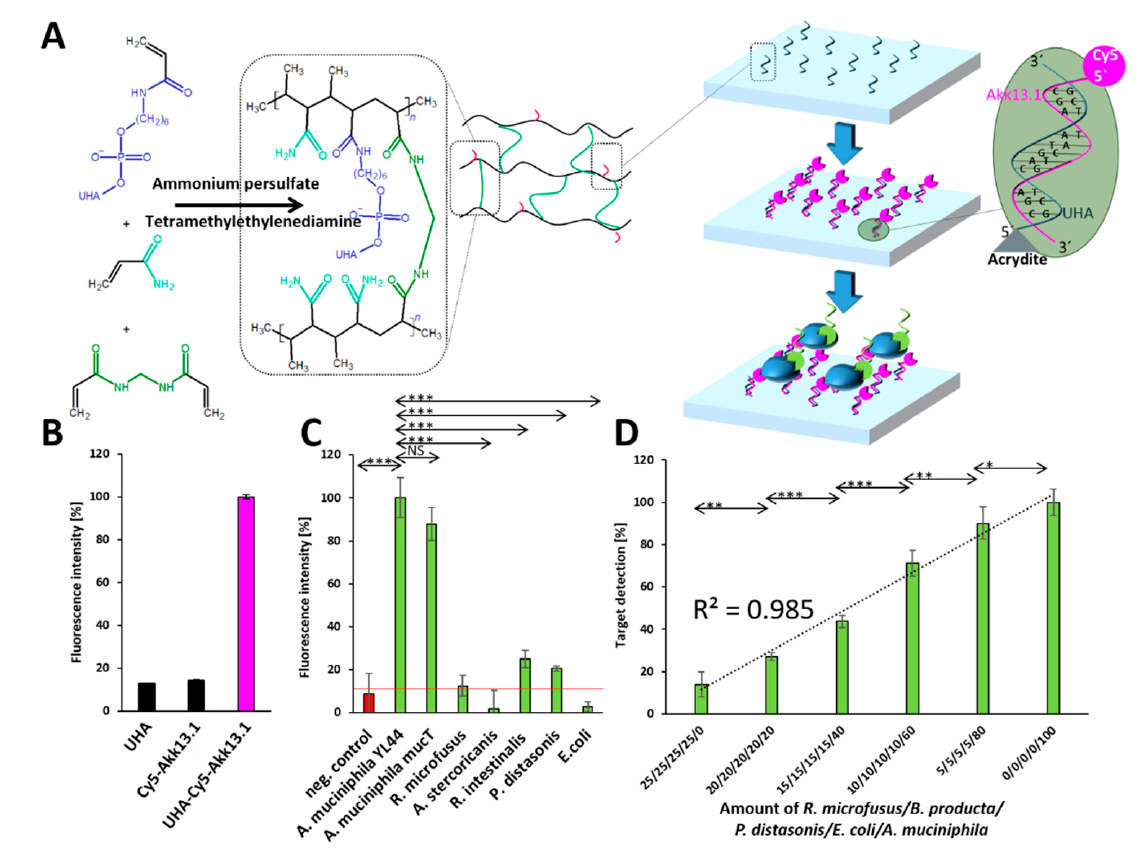
Figure 6. Design of an Akk13.1 based functional material for future biosensor applications ( A ) Reaction mechanism of the prototype aptamer-polyacrylamide based A. muciniphila detection system. The polyacrylamide-gel is modified by a universal hybridization anchor (UHA) consisting of an acrydite-modified single stranded DNA sequence complementary to the flanked regions of Akk13.1. The complementary primer binding sites of the Cy5-labeled aptamer Akk13.1 (Cy5- Akk13.1) are bound to the UHA and are able to catch specific A. muciniphila out of a sample. The second Oregon green 488 labeled “detection” aptamer Akk13.1 binds to the immobilized bacteria. ( B ) Binding control of the “catching” aptamer to the acrylamide modified primer polymerized to the hydrogel. There is a high amount of aptamer binding to the modified polyacrylamide-gel in comparison to unmodified polyacrylamide-gel ( C ) Specific detection of A. muciniphila with the Akk13.1 based functional material. The fluorescence signal of the suspension containing Akkermansia muciniphila is significant higher in comparison the signal from the gut microbiome control organism. ( D ) A. muciniphila can be retraced in mixtures with the microbiome associated organisms B. producta , R. microfusus , P. distasonis and E. coli . The mixtures contributed of varying amounts of R. microfusus/B. producta/P. distasonis/E. coli/A. muciniphila . The fluorescence signal correlates with the increasing amount of A. muciniphila . t -Test was performed where indicated with p values < 0.05 were considered significant. * denotes p < 0.05, ** p < 0.01 and *** p <